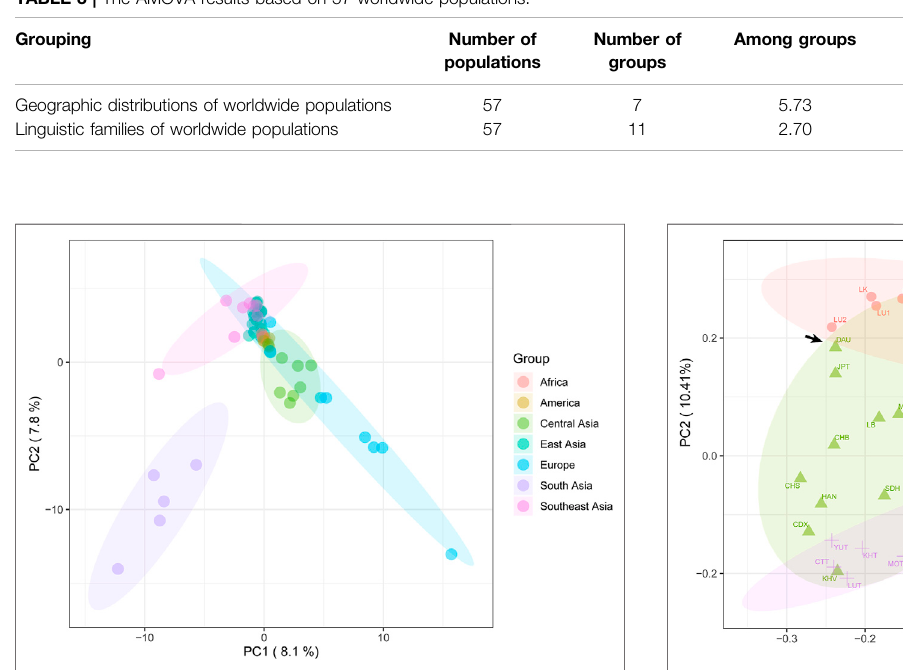
FIGURE 6 | The principal component analysis (PCA) plot for the Daur group and other Asian populations. The Daur group (DAU) is indicated with